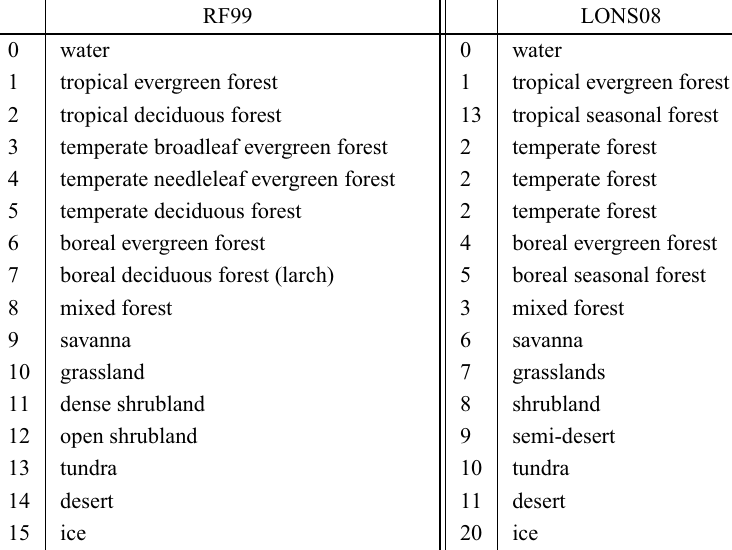
Relation between RF99 and LONS08